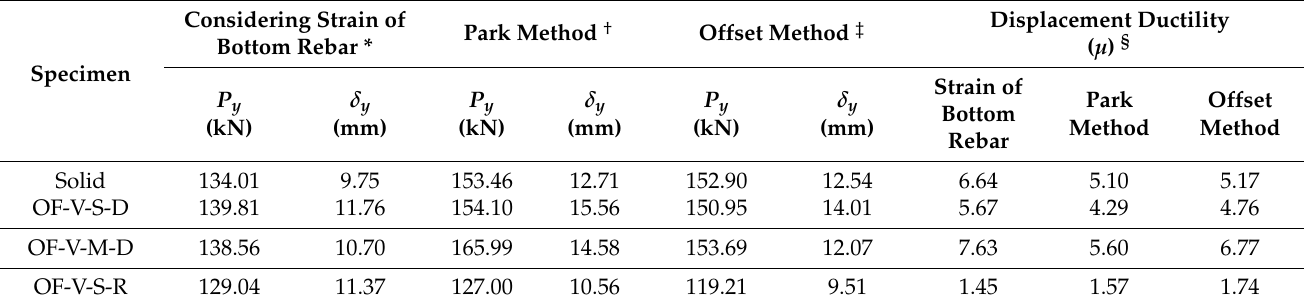
Table 8. Yield strength and displacement–ductility ratio.